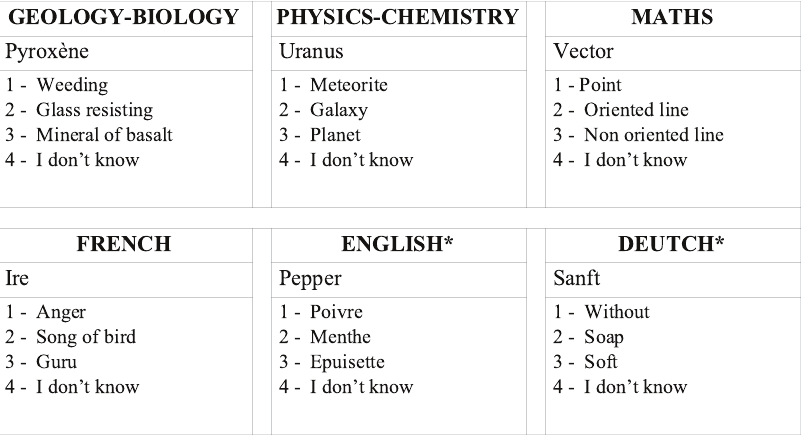
Examples ofquestions for each ofthe eight subjects in the MCQ ofgrade 8: the questionnaire comprises hundred questions by subject (800 on the whole) (adapted from MCQ in French for this